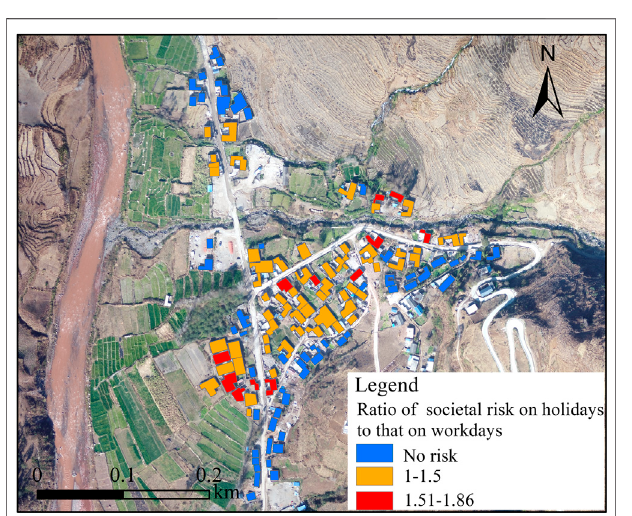
FIGURE 9 | Ratio of societal risk on holidays to that on workdays in Luomo village.